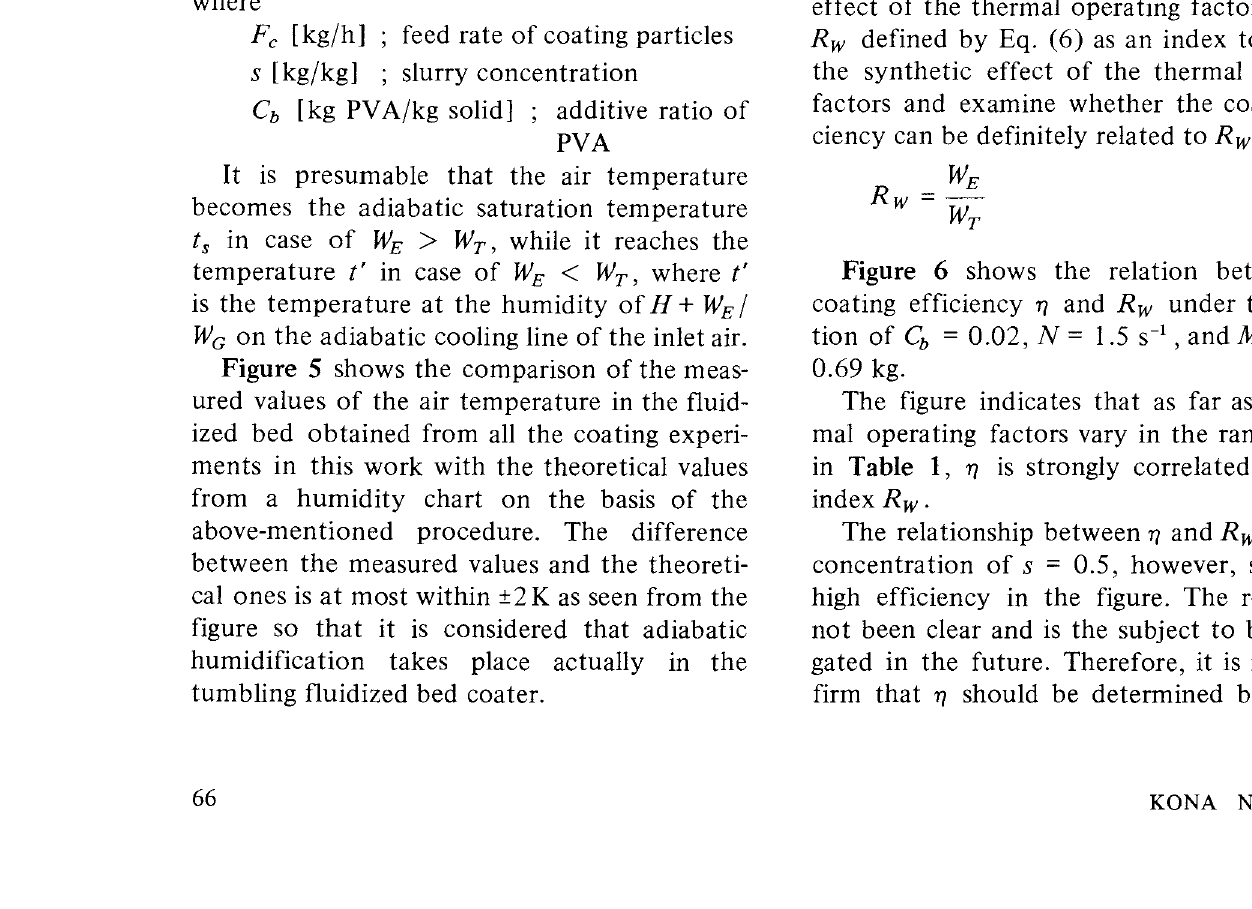
Fig. 4 Temperature and humidity variation of air through a coating apparatus